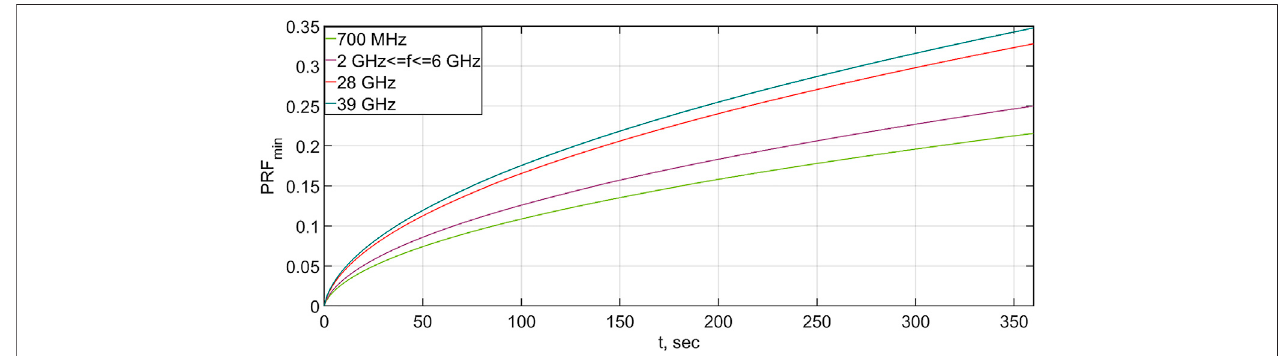
FIGURE 10 | PRF min as function of the pulse duration for some selected frequencies. For PRF values equal to or above PRF min, compliance with the whole-body time-averaged limits (over 30 min) inherently ensures compliance with the limits on brief